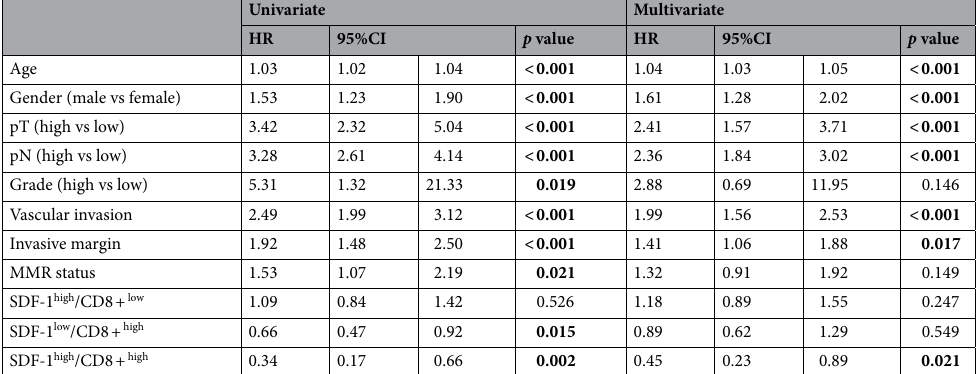
Table 4. Uni- and multivariate Hazard Cox regression survival analysis considering the combination of both markers (n = 613 and n = 576, respectively). Multivariate analyses showing Hazard Ratios and p value for all CRCs (n = 576 less than 613 due to missing values) conferred by SDF-1 expression and CD8 + cell density, age, sex, tumor size, lymph node involvement, tumor grade, vascular invasion, tumor border configuration and microsatellite stability 33 . Significant p values are